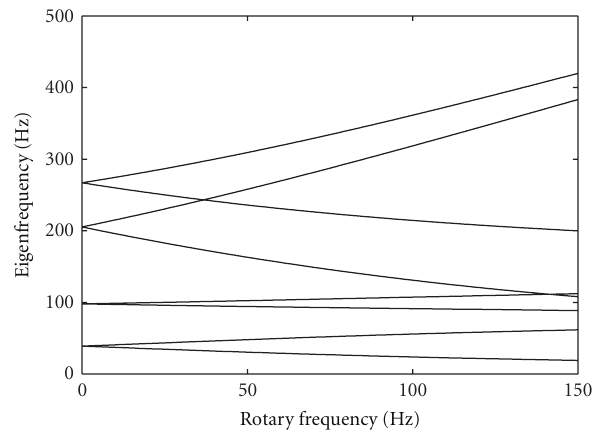
Figure 2: Campbell diagram of the rotor system.